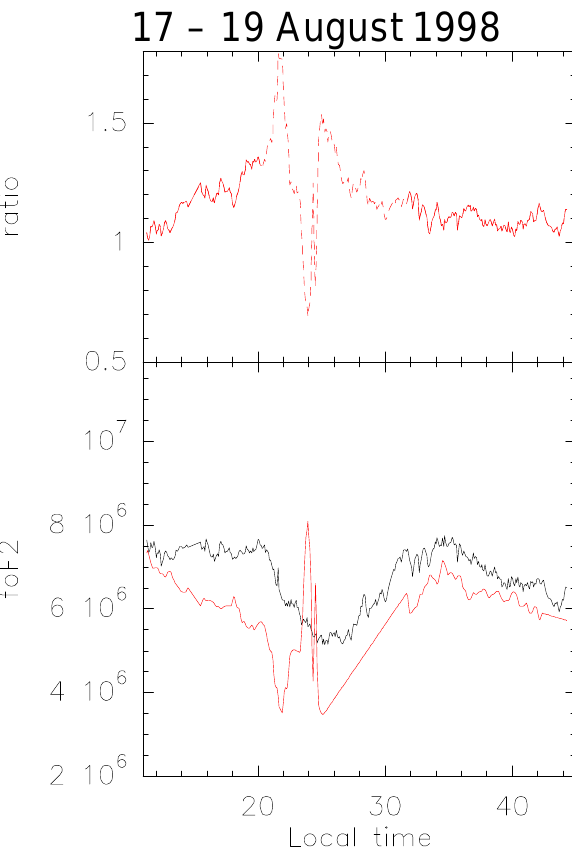
Fig. 3. fo F2 comparison between the IS radar data (black), the Dy- nasonde (red) and the DGS (green).